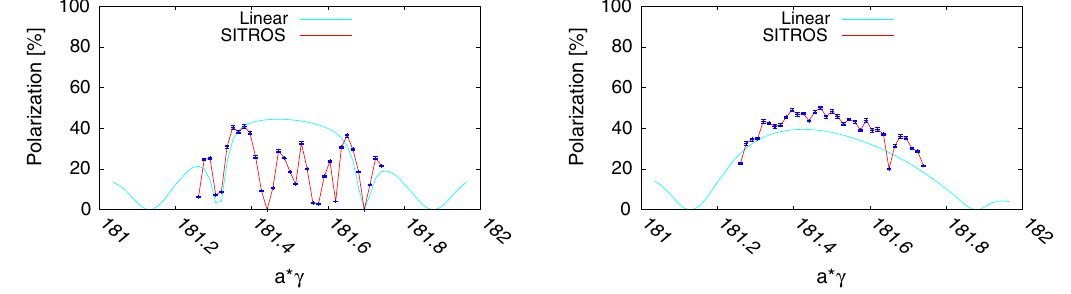
FIG. 12. Polarization vs. spin tune after orbit is corrected with SVD in presence of BPMs errors and δ ˆ n 0 is corrected with 5-correctors ¼ 0 . 3 . Right: Q ¼ 0 . 9 . harmonic bumps. Left: Q s s